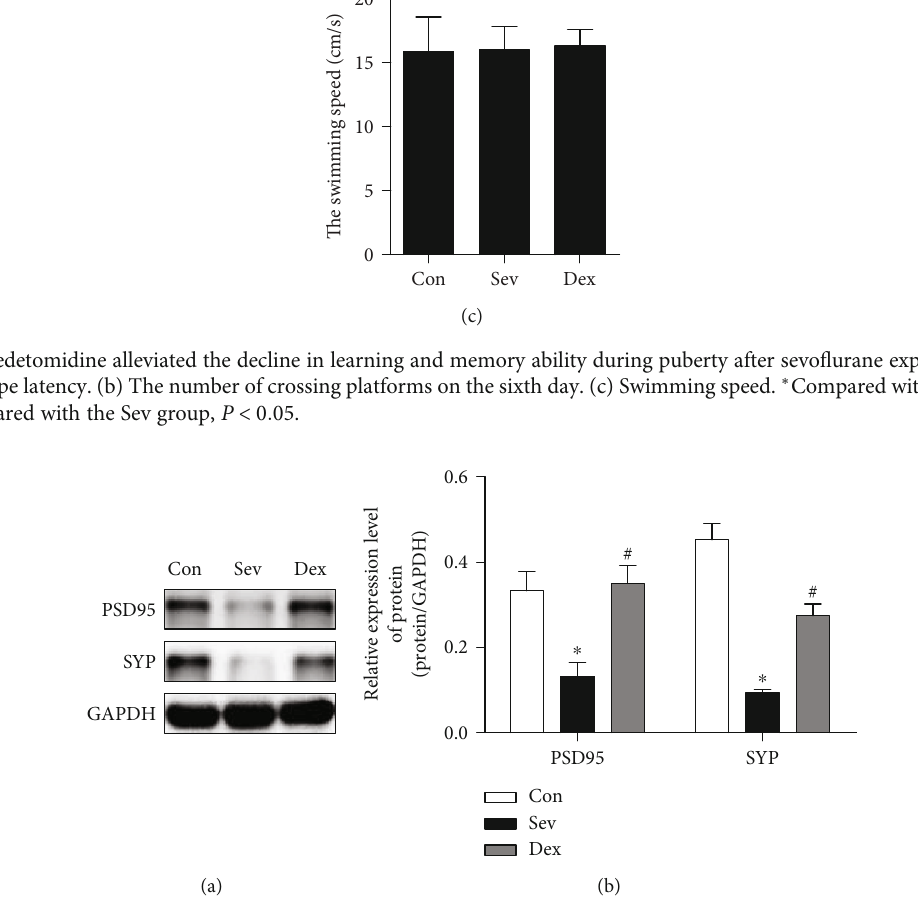
Figure 2: Dexmedetomidine improves hippocampal synaptic protein levels of sevo fl urane exposure in developing rats. (a) Western blot band. (b) Bar graph of Western blot. ∗ Compared with the control group, P < 0 : 05 . # Compared with the Sev group, P < 0 : 05